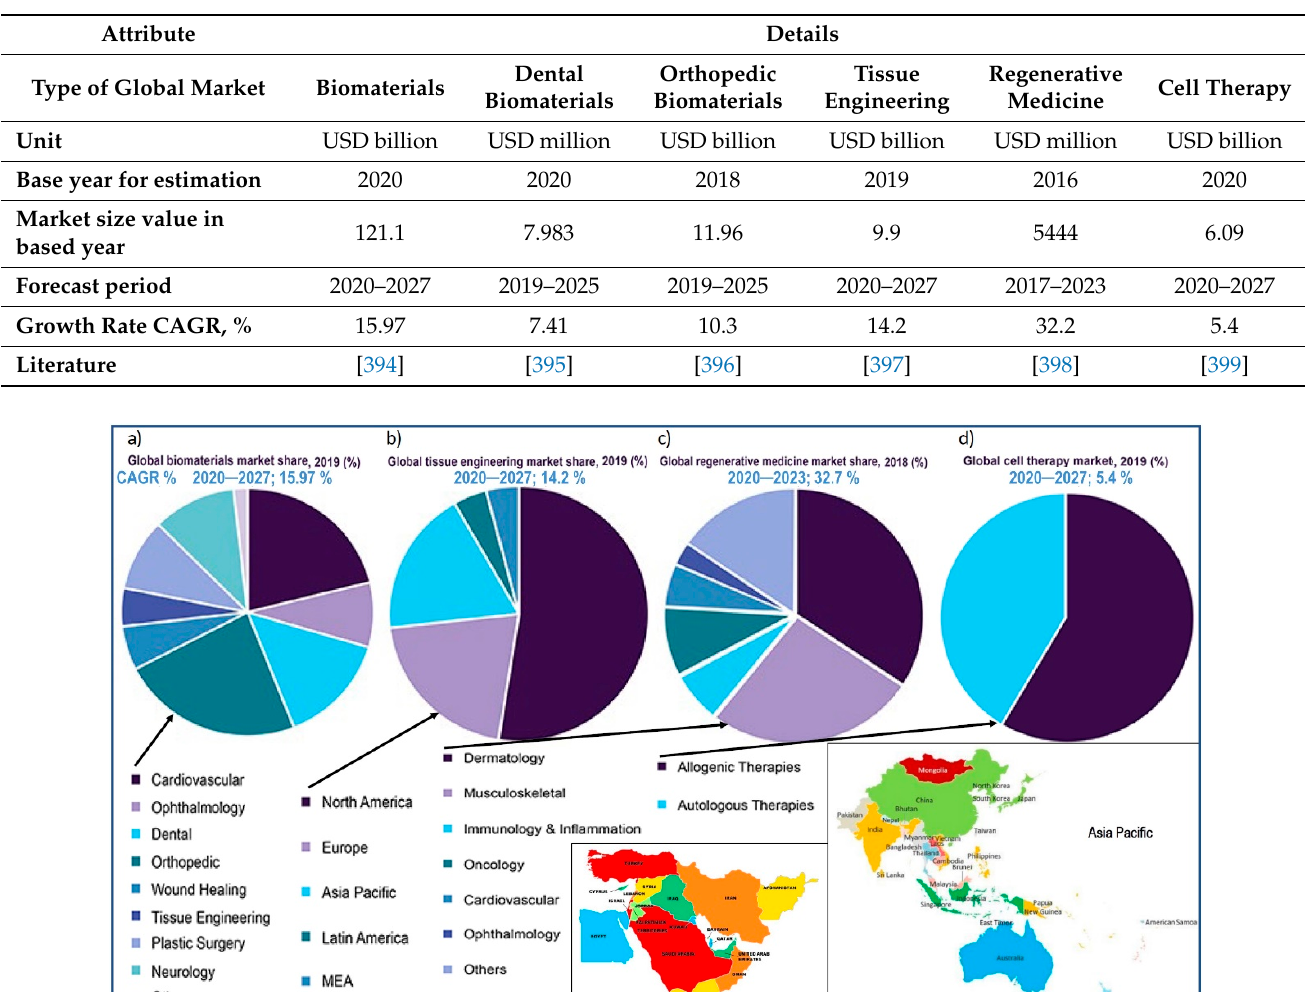
Table 3. The current value of various global biomaterial markets and the related forecast compound annual growth rates CAGR.